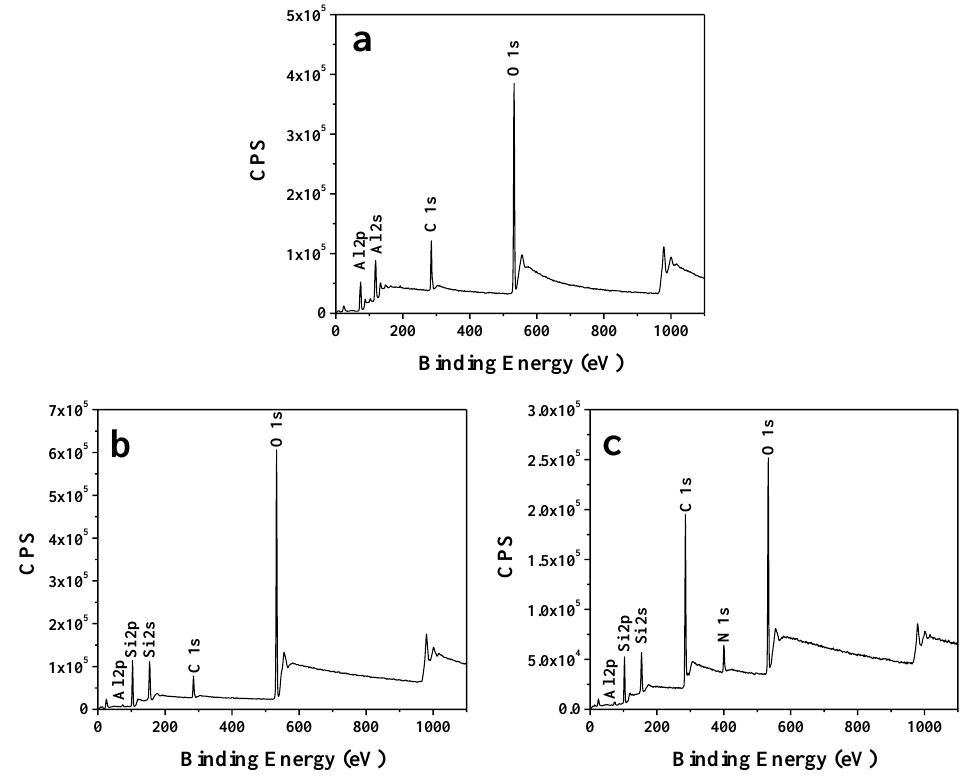
Figure 5. XPS spectra of raw aluminum pigments ( a );Al@SiO 2 ( b ); and Al@SiO 2 @PFMV ( c ).